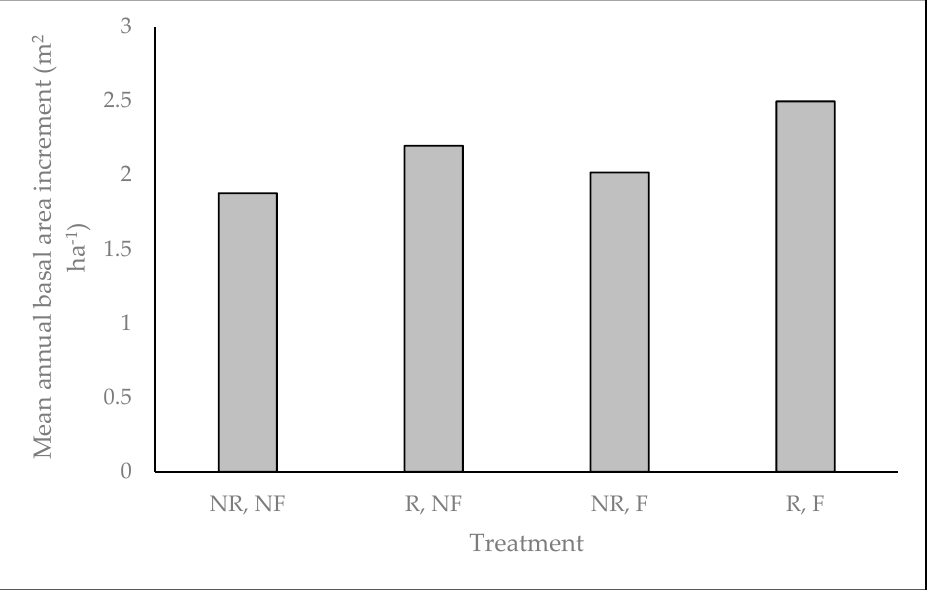
Figure 8. Mean annual basal area increment over the seven-year study period for loblolly pine by treatment [24]. Treatments: no rake, no fertilization (NR, NF); rake, no fertilization (R, NF); no rake, fertilization (NR, F); rake, fertilize (R, F) (refer to Tables 6 and 7 for study details, information on fertilizer treatments, and statistical test results).